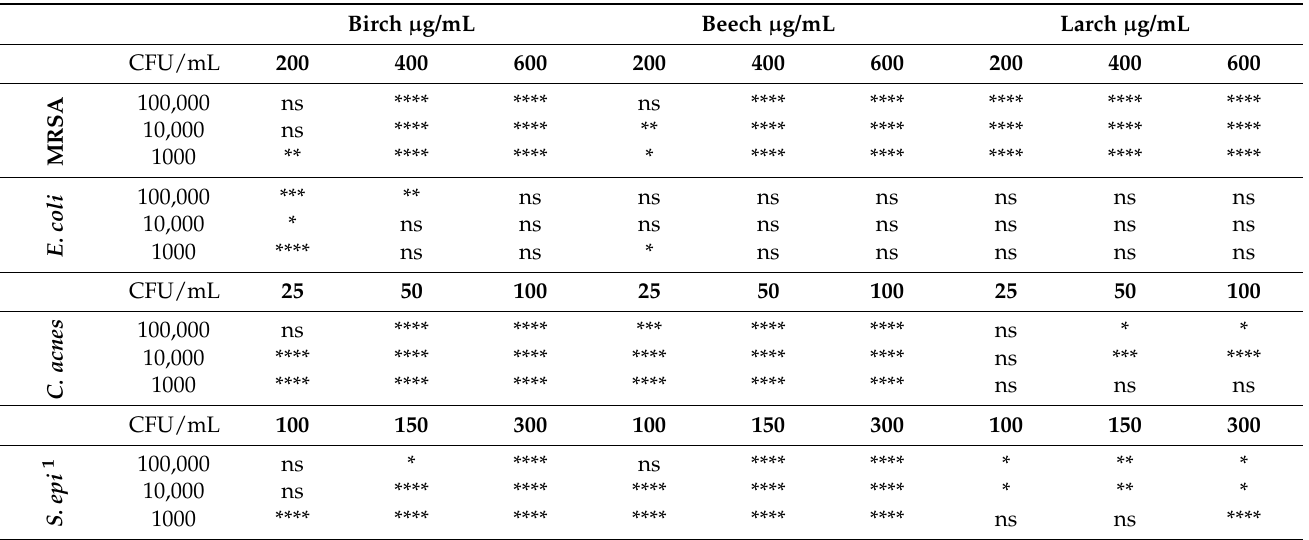
Table 2. Statistical analysis of resazurin-based broth microdilution assay for each individual seeding density with different extracts compared to